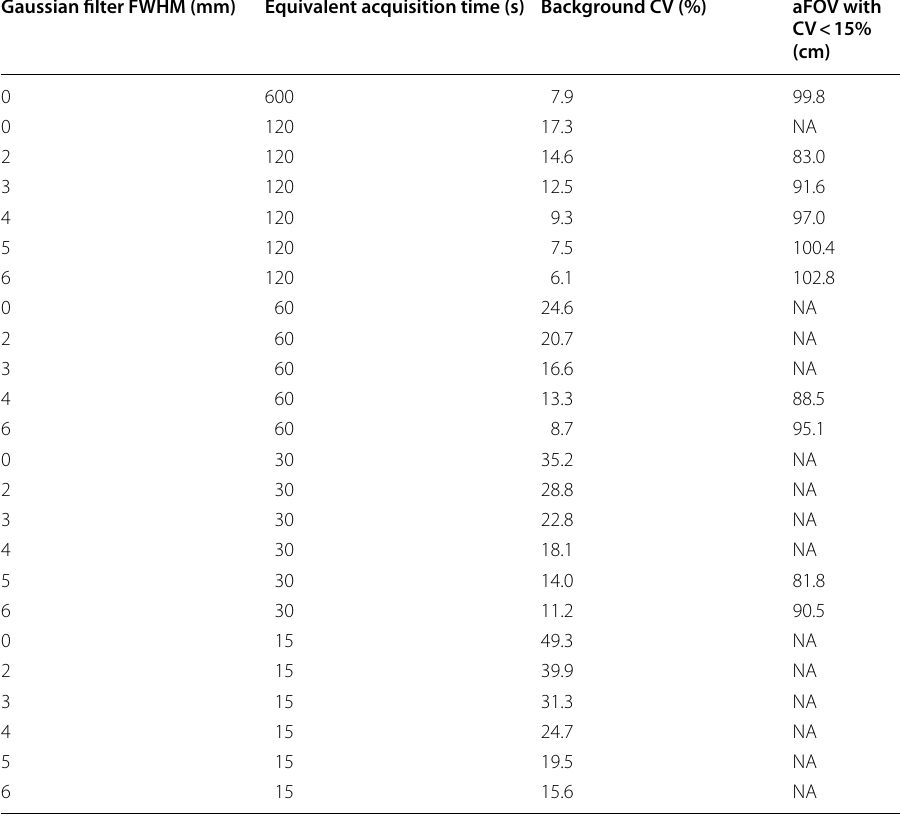
NA denotes settings where a CV < 15% could not be reached at any position throughout the aFOV